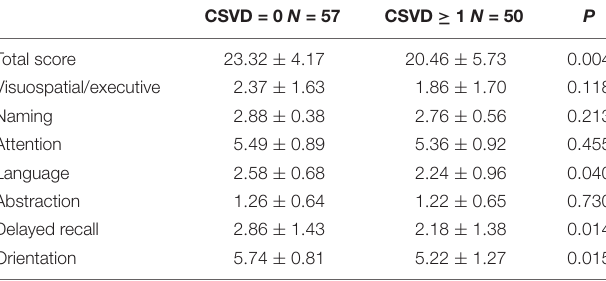
TABLE 4 | Comparison of MoCA subscores between CSVD = 0 and ≥ 1 after propensity score